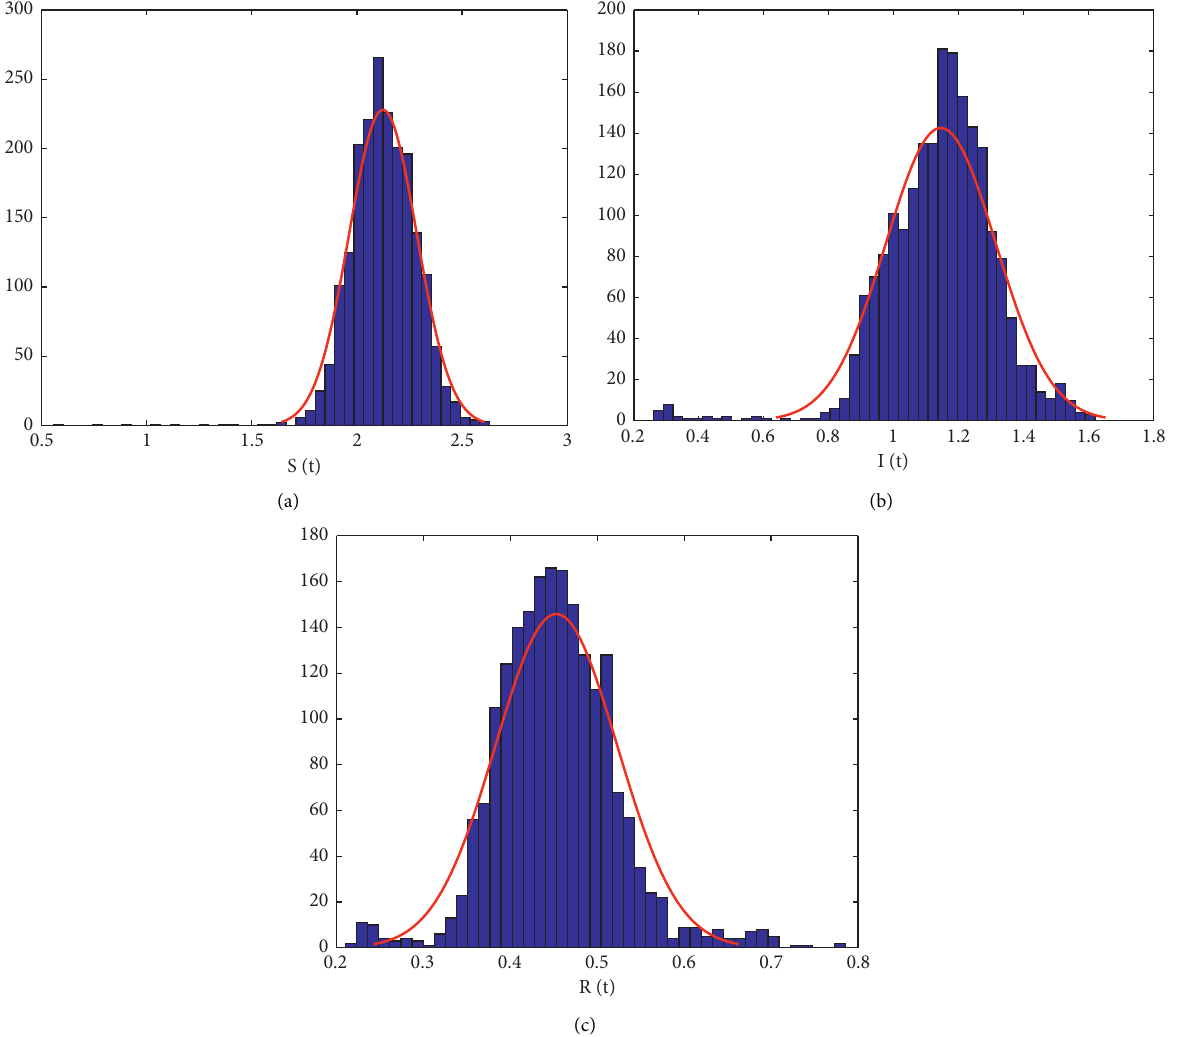
Figure 4: The histogram (a)–(c) of solution of the stochastic system (15) with R s